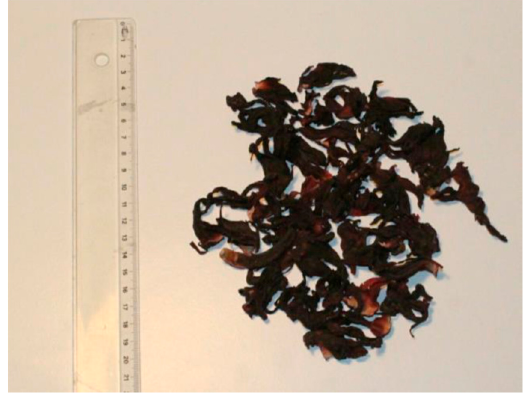
Figure 1. Herbarum photography of Hibiscus sabdariffa .